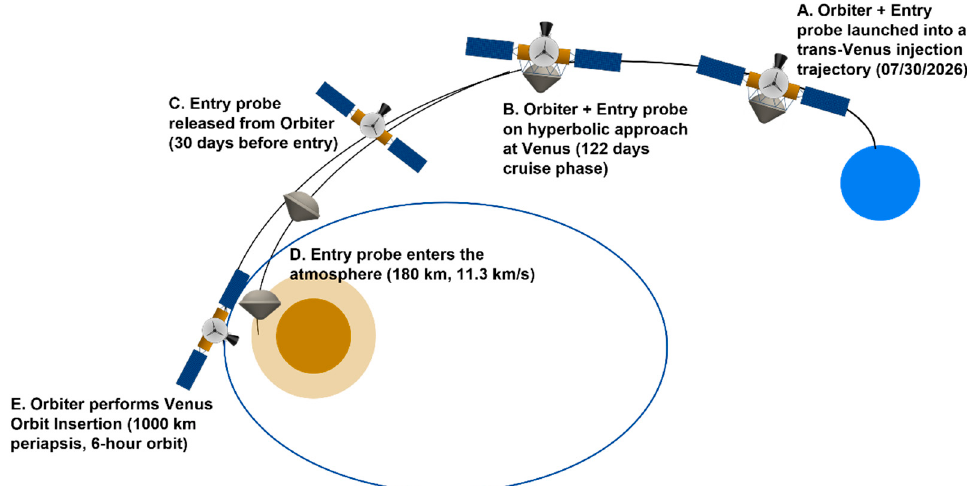
Figure 1. Overview of the launch and arrival operations. Launch occurs on 30 July 2026; Probe enters atmosphere and orbiter captures in orbit after 122 days.